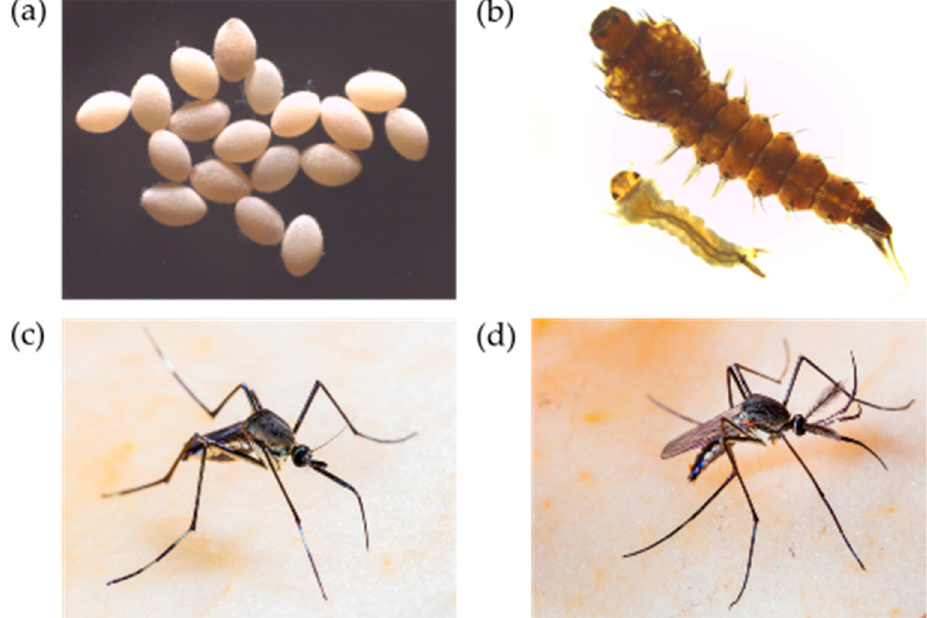
Figure 1. Toxorhynchites splendens life stages. ( a ) Eggs; ( b ) comparison between fourth instar larva of Tx. splendens and Cx quinquefasciatus ; adult ( c ) female and ( d ) male.